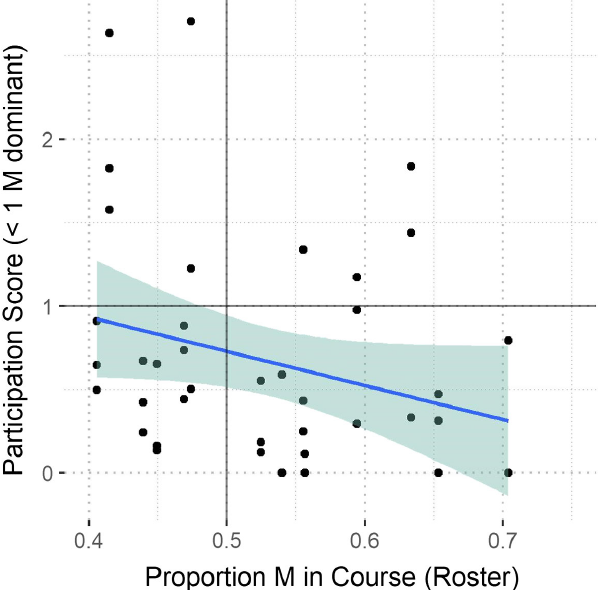
FIG. 4. . Women tend to individually participate more in women-majority physics classes. Scatterplot of physics obser- vations by gender representation in the course ( x axis) and participation score ( y axis). Simple regression lines illustrate the linear relationship between proportion of men in the course and participation scores (shaded area represents the 95% confidence interval). We find a moderate, significant correlation between participation scores and the proportion of men and women enrolled in the course, meaning we tend to find higher rates of women individually participating when there are more women in the